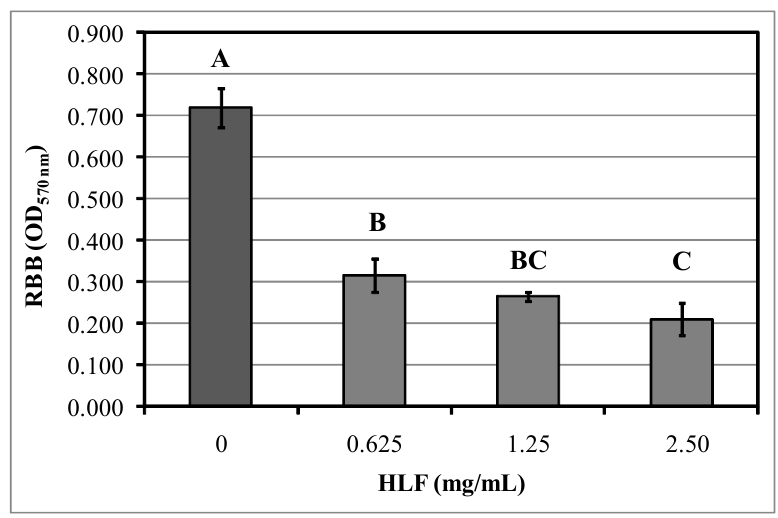
Figure 4. Residual biofilm biomass (RBB) by S. epidermidis UR63 determined on microscope cover glass slides dipped for 3 h in bovine lactoferrin hydrolysate (HLF) aqueous solution with increasing concentrations (0, 0.625, 1.25, and 2.5 mg/mL). Bars are mean values ± standard deviations. Different uppercase letters above bars represent statistically different values according Tukey’s test ( p < 0.05; n = 3).